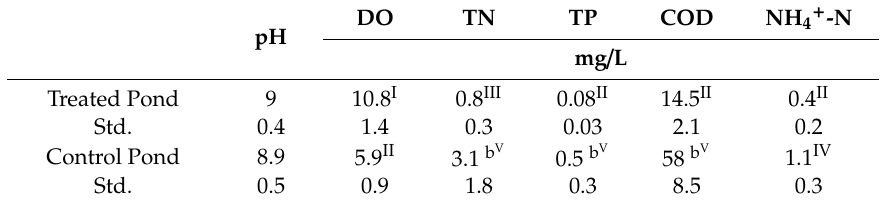
Table 2. The mid-term e ff ect of MLS treatments on water quality after 70 days in the control and treatment